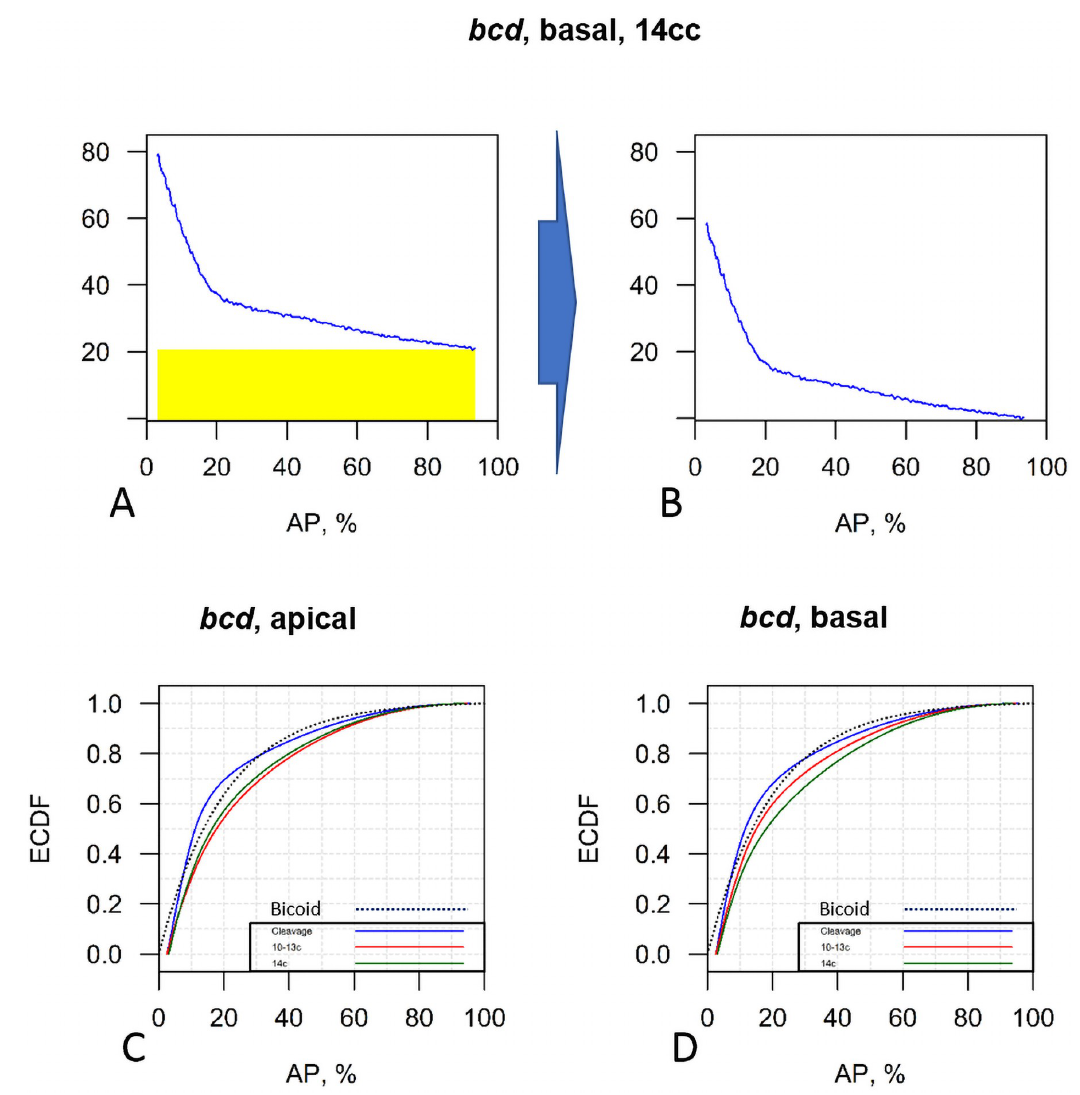
Fig 15. Cumulative distribution of the bcd mRNA fluorescence intensity critically depends on the background definition (cumulative plot of Fig 5 data). (A-B) The simplest hypothesis of a flat background (A) produces a bcd mRNA profile which is comparable to the Bcd protein gradient up to the beginning of cycle 14 (B). (C-D) Profiles from Fig 5 had uniform background subtracted, and are then plotted as cumulative curves. The blue dotted line is the approximation of a Bcd gradient with the length constant = 20%EL (see text). ECDF—empirical cumulative distribution